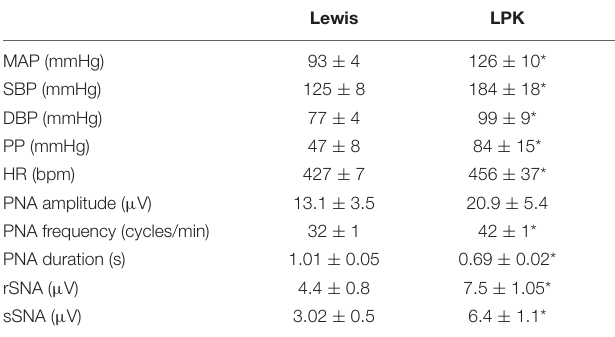
TABLE 1 | Baseline cardiorespiratory function in female Lewis and LPK